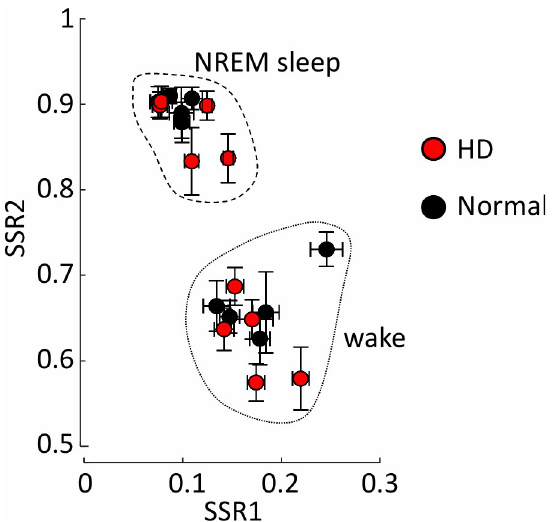
Fig 2. Comparison of sleep states in normal and Huntington’s disease sheep. Scatter plot showing the mean state space ratio locations for all epochs in each sheep (N = 5 for each genotype) separated by the automated scoring method. NREM sleep and wake epochs are enclosed by dotted lines to show the separation. There are no differences in the locations of the mean state space ratios for NREM sleep and wake between HD (filled circles) and normal (empty circles) sheep. Data shown are means taken across all channels, error bars are standard deviation. Each sheep is represented by an individual symbol. Note that some symbols